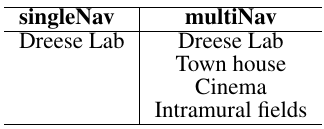
Table 1. Training goal settings